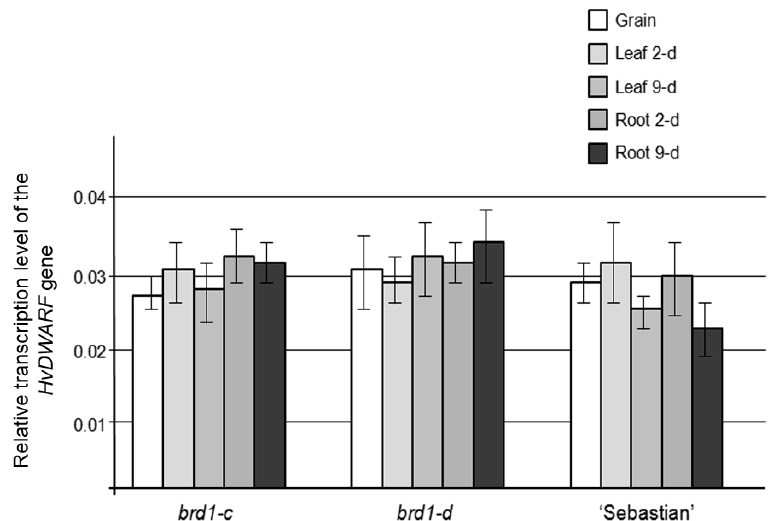
Figure 8. Transcription profile of the HvDWARF gene in the mutants with the brd1-c and brd1-d alleles and the parental variety “Sebastian” during early stages of barley seedling development. Transcription level of the reference gene HvG3PD (NCBI GenBank: X60343) on this diagram is equal to 1.0. Mean values of three replications are shown with error bars representing standard deviation. Values obtained for each of the developmental stages were compared between genotypes. Differences were not found statistically significant ( p ≤ 0.05).